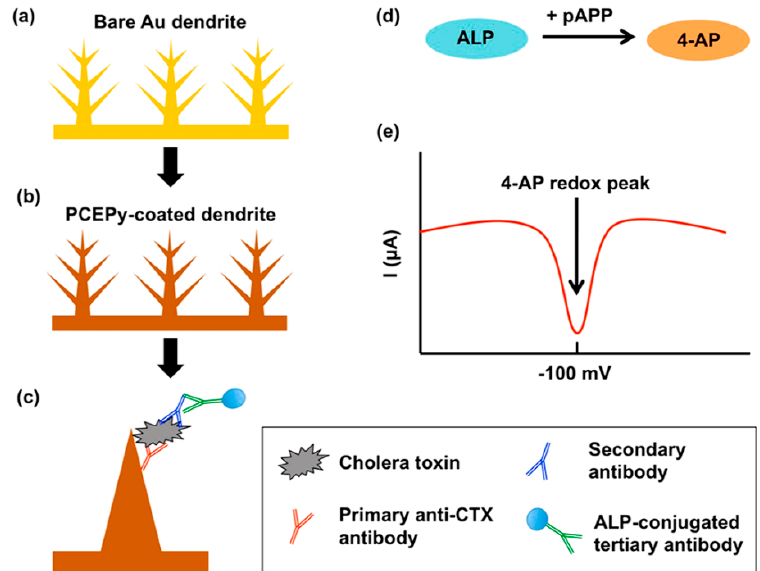
Figure 10 . Schematic overview of the dendrite-based on-chip enzyme linked immunosorbent assays (ELISA). ( a ) Dendrites grown on a planar gold substrate. ( b ) Dendrites coated in a film of poly(2-cyanoethyl)pyrrole (PCEPy). ( c ) Primary antibody to cholera toxin (CTX), tethered to PCEPy-coated dendrites via electrostatic interactions. Secondary anti-CTX antibody, and tertiary antibody are added, with wash steps between each. ( d ) Alkaline phosphatase (ALP) conjugated to the tertiary antibody reacts with the substrate p-aminophenyl phosphate (pAPP) to form 4-aminophenol (4-AP), which ( e ) oxidizes at − 100 mV vs a pseudo Ag / AgCl reference electrode. This redox peak is proportional to the amount of CTX in the sample. Reproduced with permission from [73].